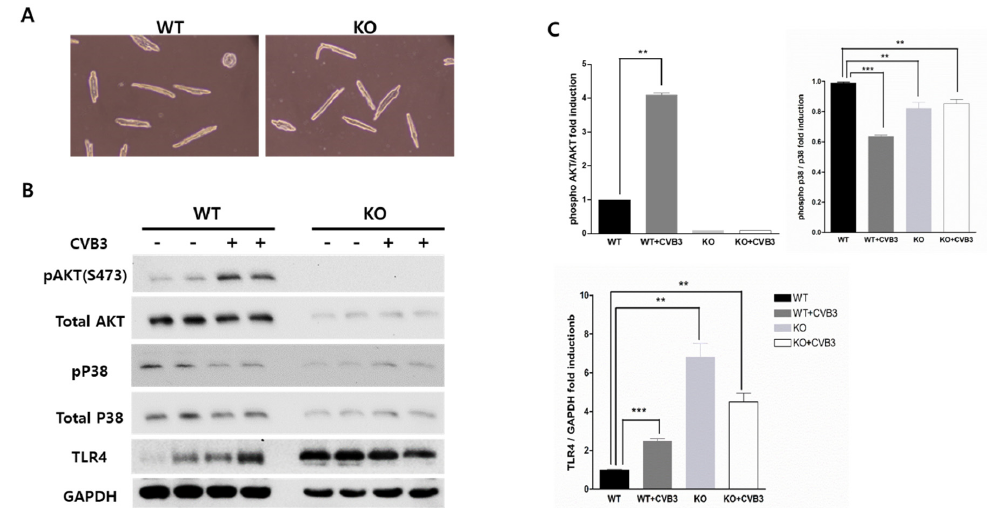
Figure 6. AKT2 deletion increased TLR-4 expression in isolated adult cardiomyocytes. ( A ) Adult cardiomyocytes were isolated from the hearts of WT and KO mice. Cell extracts were subjected to Western blot analysis using the indicated antibodies. ( B , C ) TLR-4 immunoblotting bands indicate the fold changes in TLR-4 normalized to GAPDH bands, and pAKT and pP38 bands normalized to total Akt and P38 bands. All data are the means ± s.e.m. from independent experiments. ** p < 0.01 and *** p < 0.001 according to a two-tailed Student’s t -test.